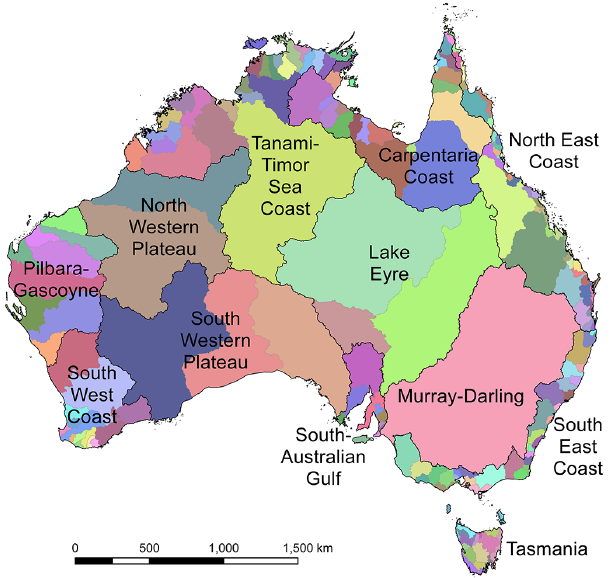
Figure 6. Levels 1 and 2 of the new hierarchically nested catchment framework. Shown are the Level 1 topographic drainage division